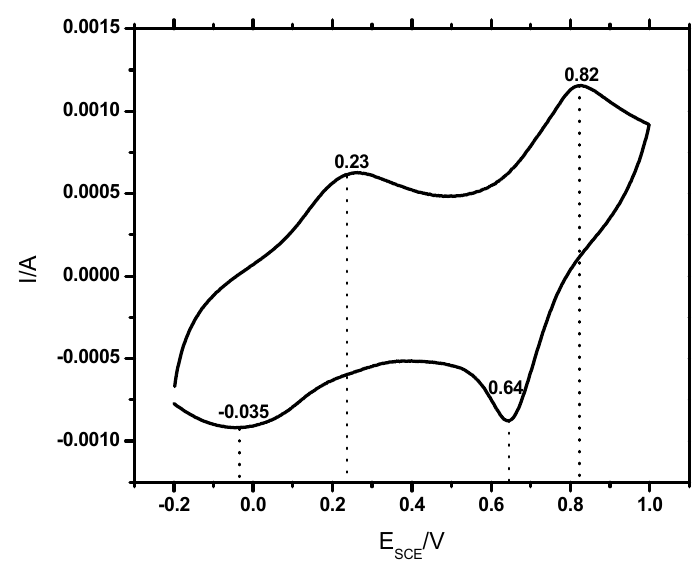
Figure 11. Cyclic voltammogram of PANI salt coated on a gold sheet electrode, in 0.5 M H 2 SO 4 at a scan rate of 50 mV/s.